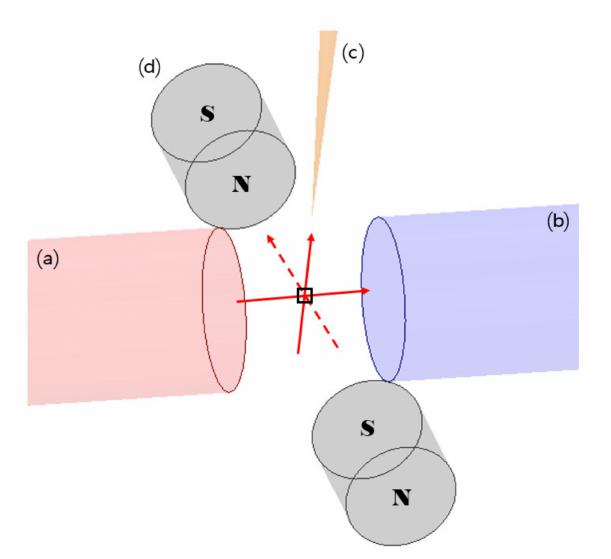
Figure 4. Maxwell simulation model of superconducting arc-induction type DC circuit breaker.